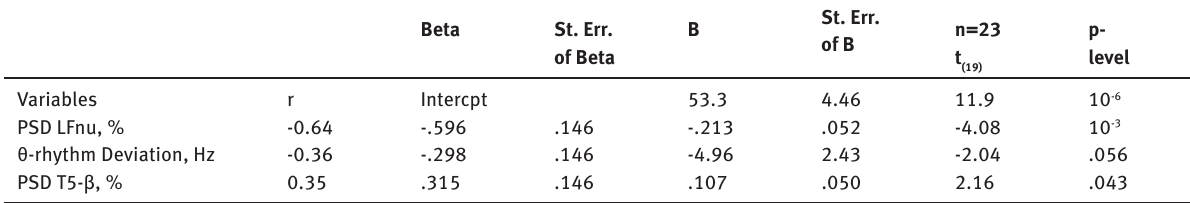
Table 6: Regression Summary for Dependent Variable: